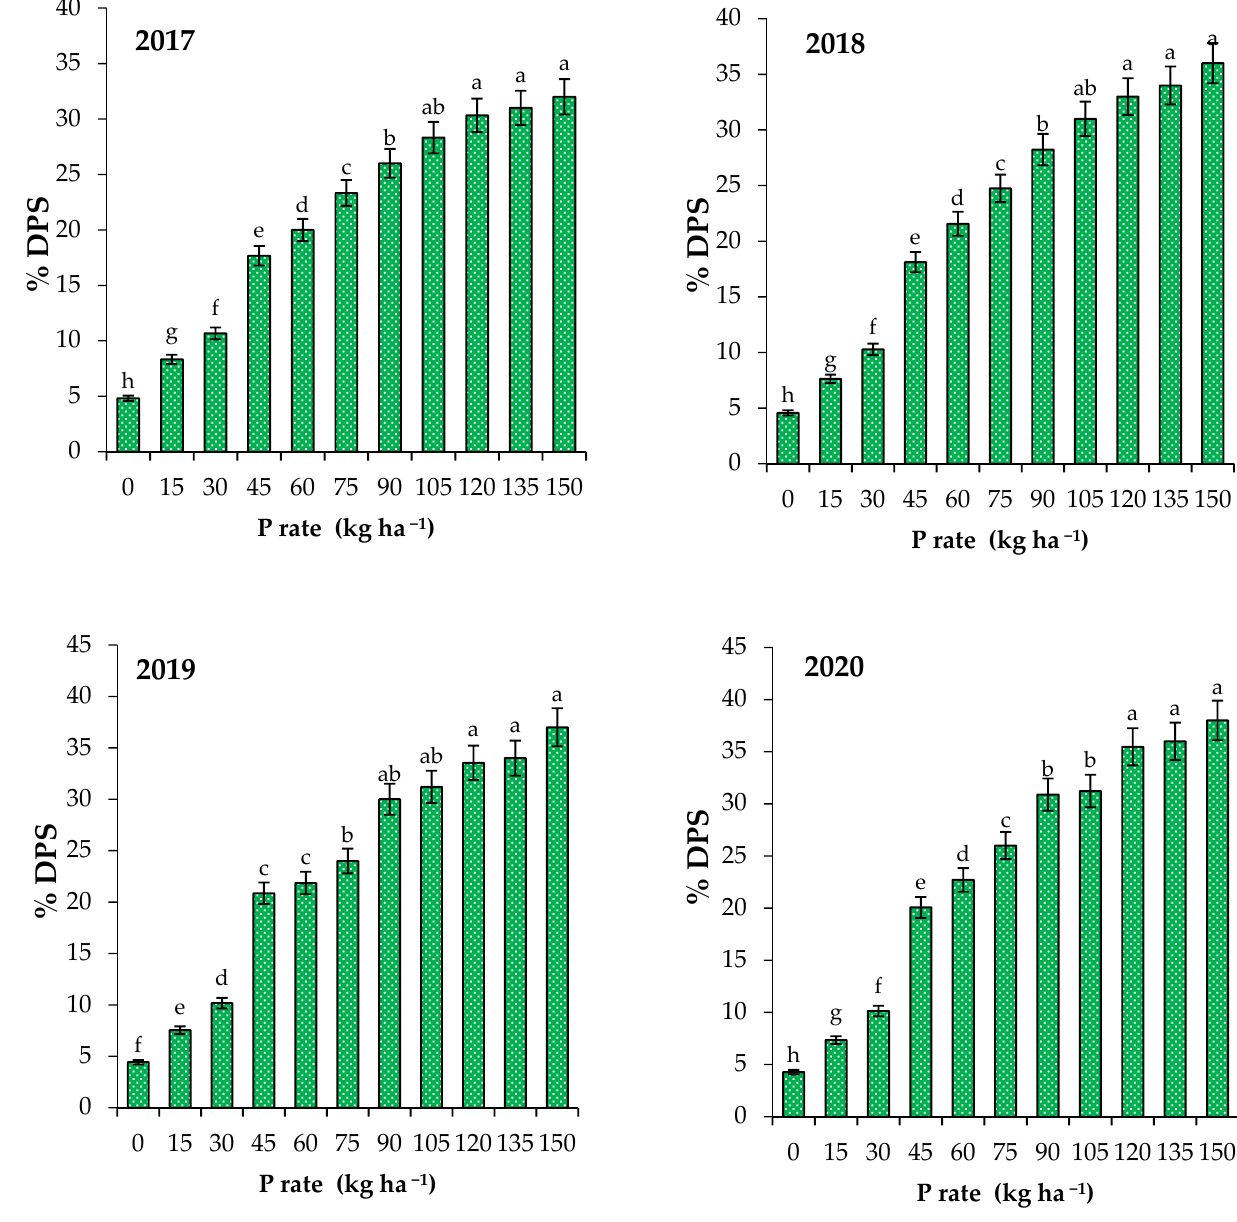
Figure 2. The degree of phosphorus saturation (DPS) as affected by fertilization rates during the four growing seasons (2017–2020). Means denoted by different letters indicate significant difference according to Duncan’s test at p < 0.05.